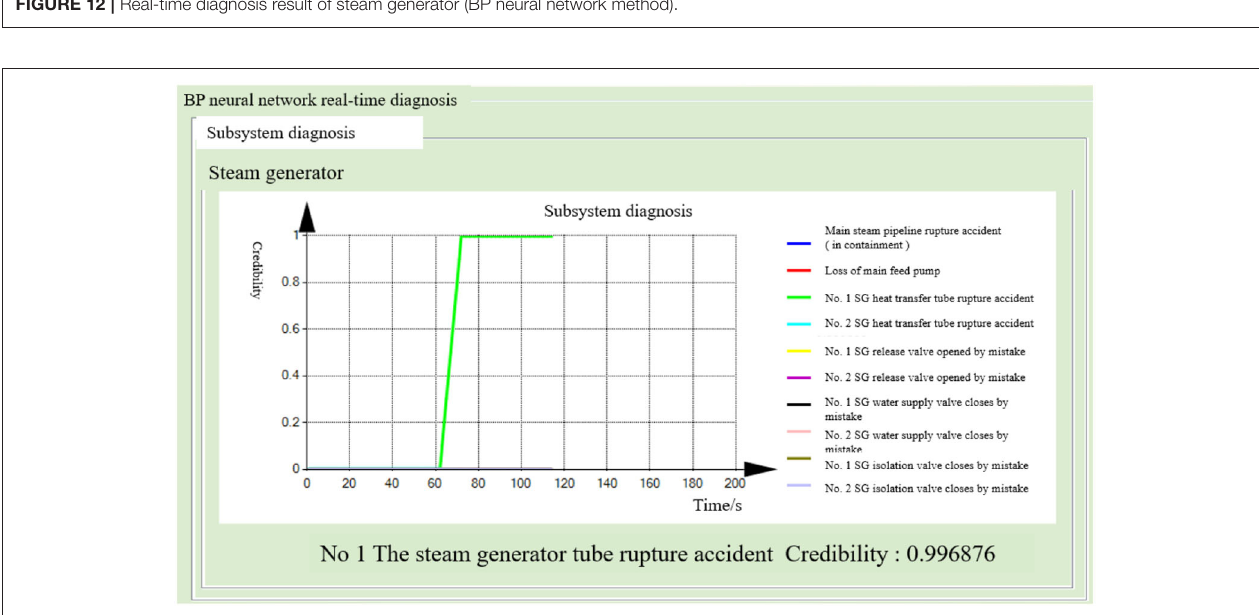
FIGURE 13 | Real-time diagnosis results of the main water supply system (BP neural